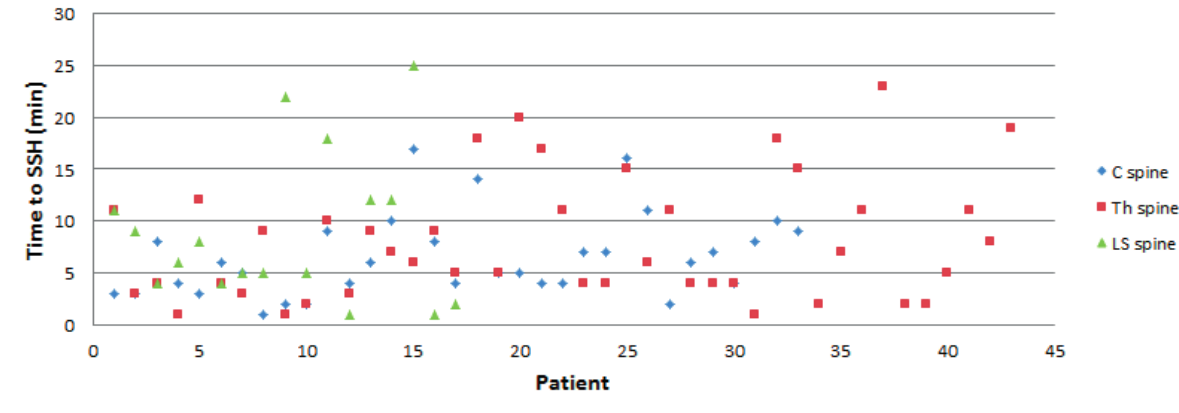
Fig. 2. Time to spine significant shift (SSH) for the cervical (C spine), thoracic (Th spine), and lumbar-sacral (LS spine) regions of the spine. Some points overlapped.